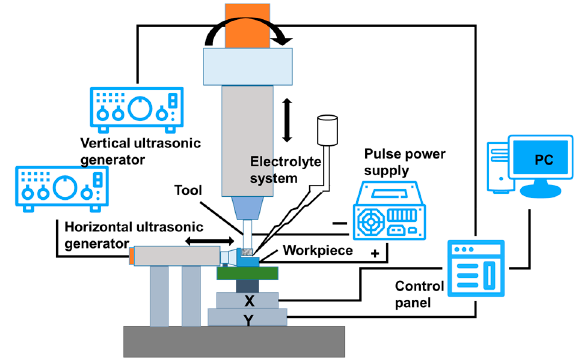
Figure 4. 2D-RUCEGM